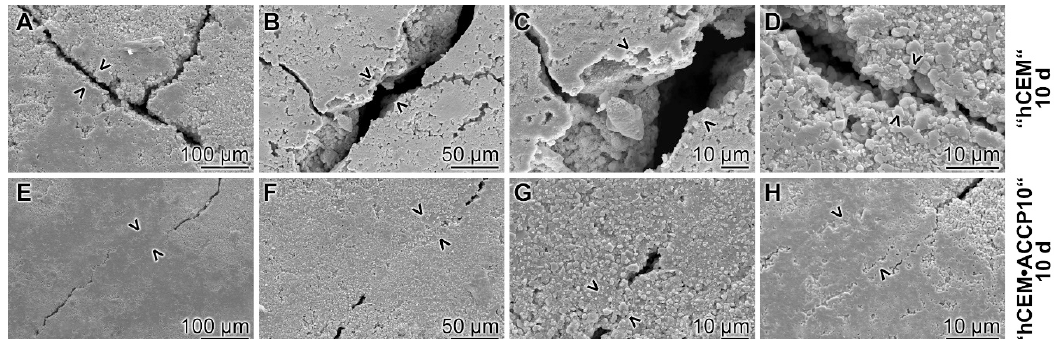
Figure 9. Self-healing potential of “hCEM • ACCP10” cement. Microcracks ( > < ) were introduced into “hCEM” ( A – D ) and into “hCEM” supplemented with “ACCP10” ( E – H ) and the samples